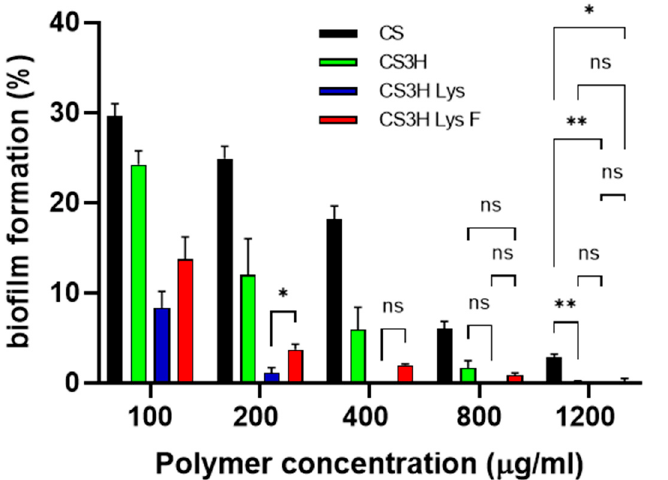
Figure 4. Effect of chitosan polymers on the growth of S. mutans biofilms. Data are reported as mean ± SD, n = 6. Data were analyzed by two-way ANOVA (both polymer and concentration effect returned p < 0.0001) followed by Tukey’s multiple comparisons; all comparisons between polymers at different concentrations returned p < 0.001 unless otherwise indicated in the graph; * p < 0.05; ** p < 0.001; ns = non-significant.